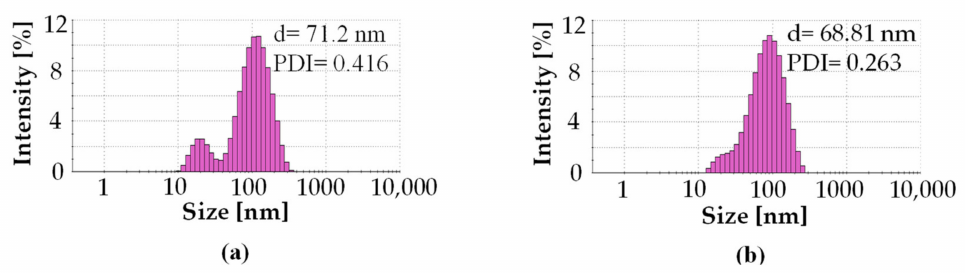
Figure 3. DLS histograms of AgNPs prepared with 5 mL of extract ( a ) and 5 mL of infusion ( b ) of C. incanus .